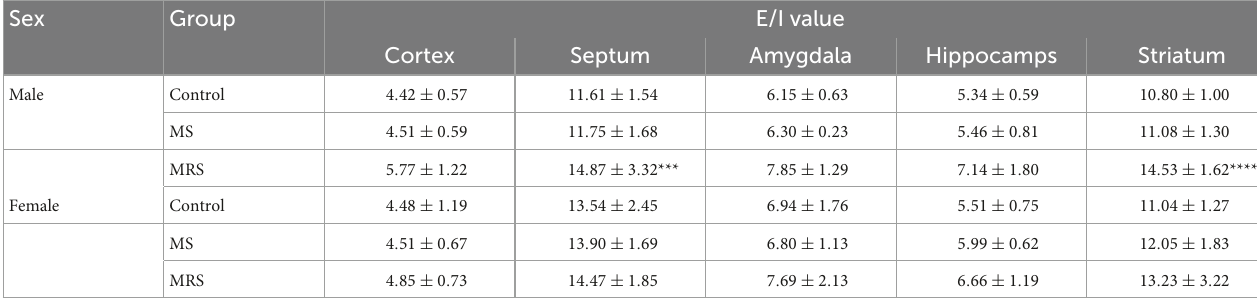
TABLE 2 Comparison of the regional E/I ratio values.